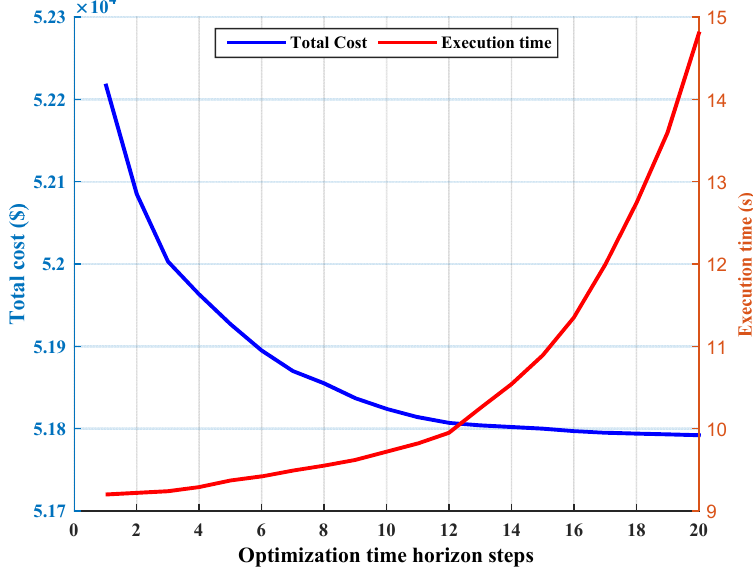
Figure 12. Performance analysis of the MPC approach regarding different optimization time horizon steps.